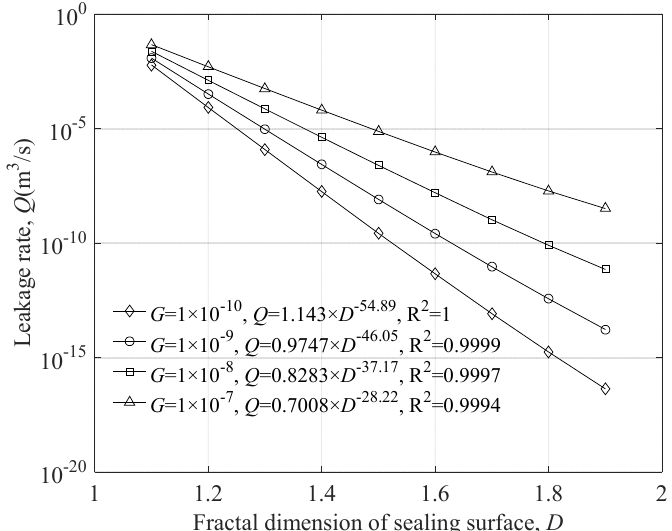
Figure 17. The influence of fractal parameters on the leakage rate.